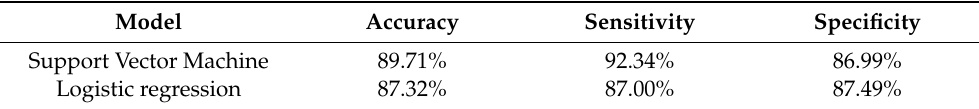
Table A10. SVM and Logistic regression scores when trained on the seven paintings dataset using DGI